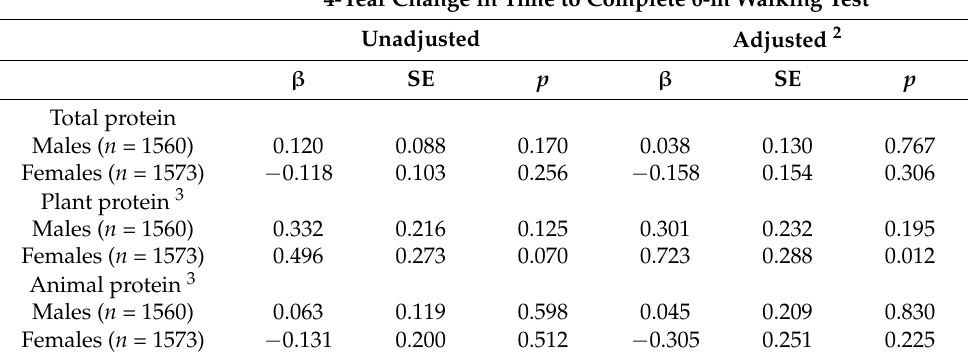
Table 2. Associations between baseline relative protein intake (g/kg of body weight) and change in physical performance over 4